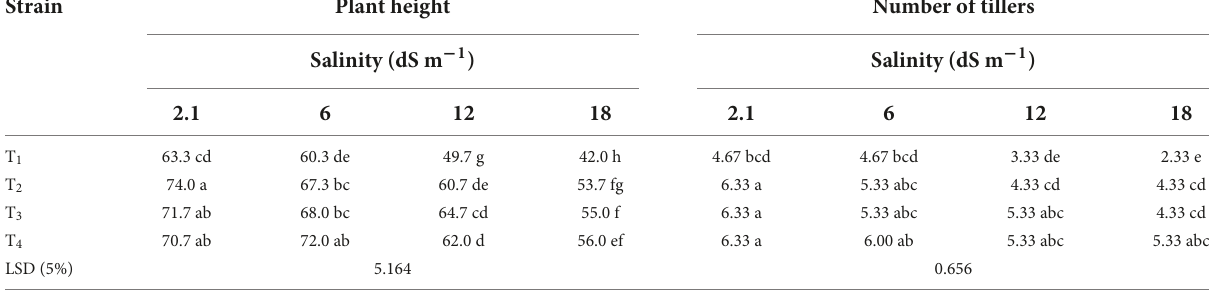
TABLE 3 Effect of inoculation with multi-strain bacterial consortium on plant height (cm plant − 1 ) and the number of tillers of wheat at different salinity levels in a pot trial. Strain